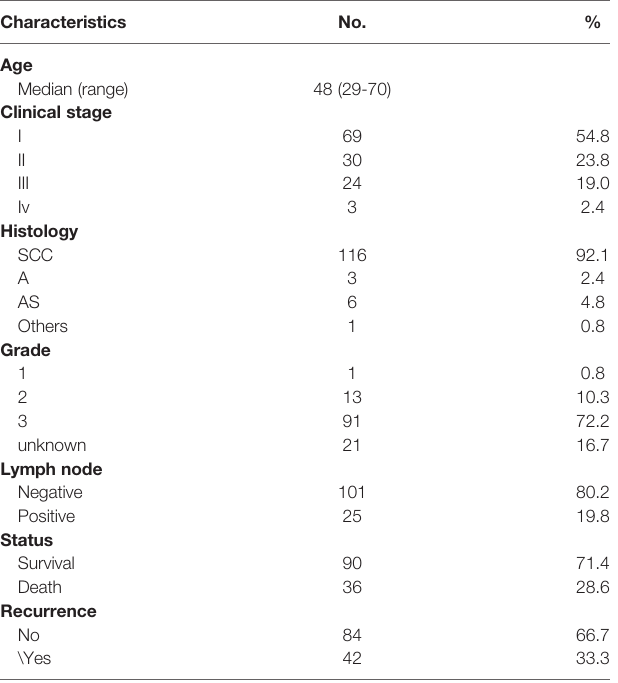
TABLE 1 | Clinicopathological characteristics of 126 patients at initial presentation.